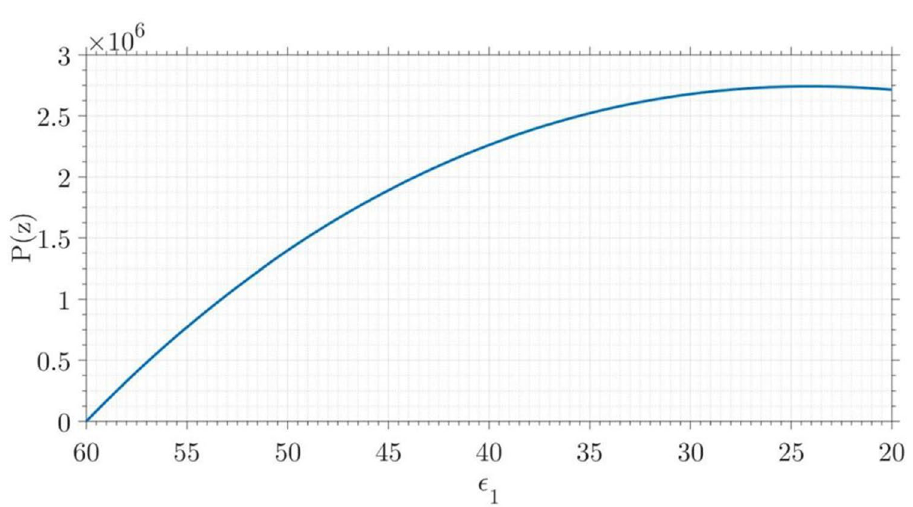
Figure 17. Polarization moment vs. the permittivity of the